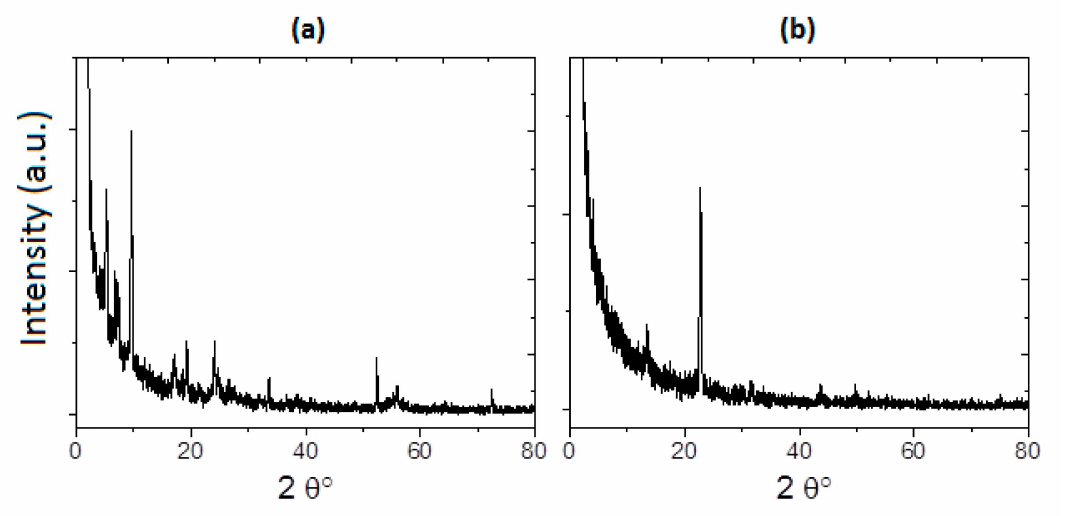
Figure 1. XRD for ( a ) TTF deriv -CuPc and ( b ) TTF deriv -ZnPc thin films at 393 K.